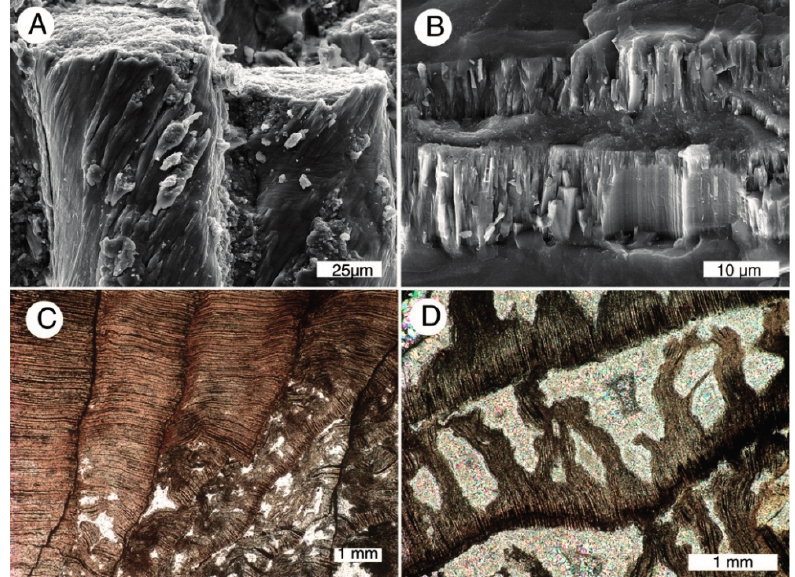
Figure 7. Examples of chalcedony. ( A ) Tracheids with cell walls mineralized with solid chalcedony, lumina filled with granular chalcedony; ( B ) Fibrous structures are, locality 10; ( C , D ) Transmitted light view of transverse silicified wood showing disordered structure caused by decay. Openings between permineralized cells are filled with chalcedony, location 7.